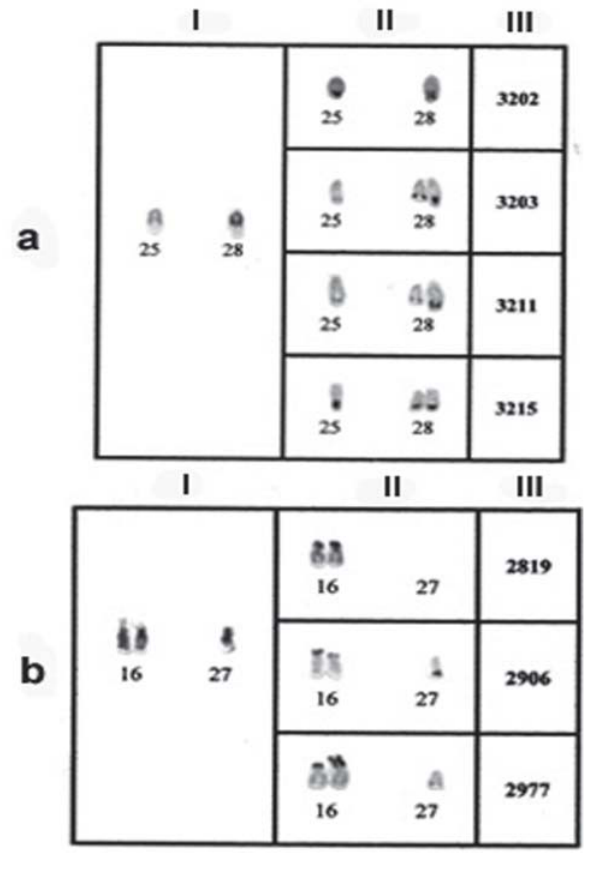
Fig. 3. Chromosomes bearing of Hypostomus nigromaculatus secondary constriction: a= sample from rio Mogi-Guaçu and b= sample from tributaries of the rio Tibagi; I- Giemsa-stained; II- silver nitrate staining; III- number of specimens